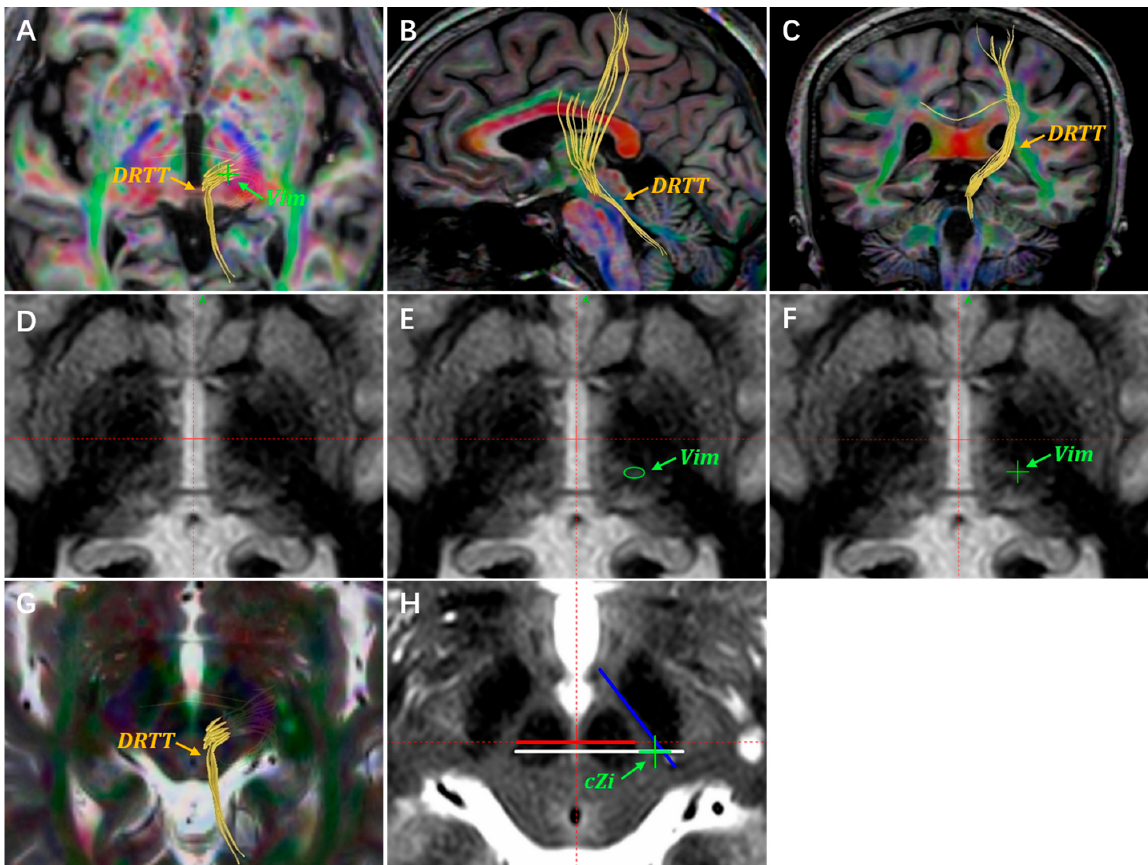
Figure 1. A demonstration of target planning for the Vim and PSA. Targets are located through the atlas-defined stereotactic coordinates, DTI images, and FGATIR images. ( A ) The DRTT is delineated using DTI tractography on the axial anterior commissure–posterior commissure (AC-PC) plane. The Vim target is located on the DTI images, indicated with a green “+”. The DRTT is delineated by the DTI images on the sagittal ( B ) and coronal planes ( C ). ( D ) Unannotated axial FGATIR images, 1 mm below the AC-PC plane. ( E ) The Vim nucleus region is delineated with a green circle on the axial FGATIR images. ( F ) The green “+” represents the planned Vim target. ( G , H ) The cZi lies laterally to the DRTT on the most prominent RN layer. The green “+” represents the planned cZi target, which is usually located on the axial T2WI images. 3.2. Targets Adjustment Upon obtaining patient consent, we implanted double-target electrodes in patients with ET. Making subtle adjustments for double-target analysis is challenging, but it is of- ten necessary during the operation. When the widths of the lateral ventricle and third ventricle are enlarged (such as due to brain atrophy in the elderly), the Vim target corre- spondingly shifts laterally. This may increase the coronal angle of the double-target tra- jectory. If the coronal angle exceeds 30 degrees, the risk of the trajectory traversing critical brain regions greatly increases. This includes the frontal language area, internal capsule, and other functional areas. When the locations of both targets have been confirmed, the coronal and sagittal angles of the double-target trajectory are fixed. The only way to adjust the trajectory is by making subtle adjustments to the locations of both targets. However, there is currently a lack of specialized descriptions for target adjustment. Papavassiliou et al. proposed that the optimal electrode location for Vim-DBS corresponds to the anterior margin of the Vim [33]. The authors noted that electrode deviations more than 2 mm from the optimal coordinate were associated with poor tremor control. Cury et al. agreed with this assessment and proposed that stimulations of the Vim caudal area were associated